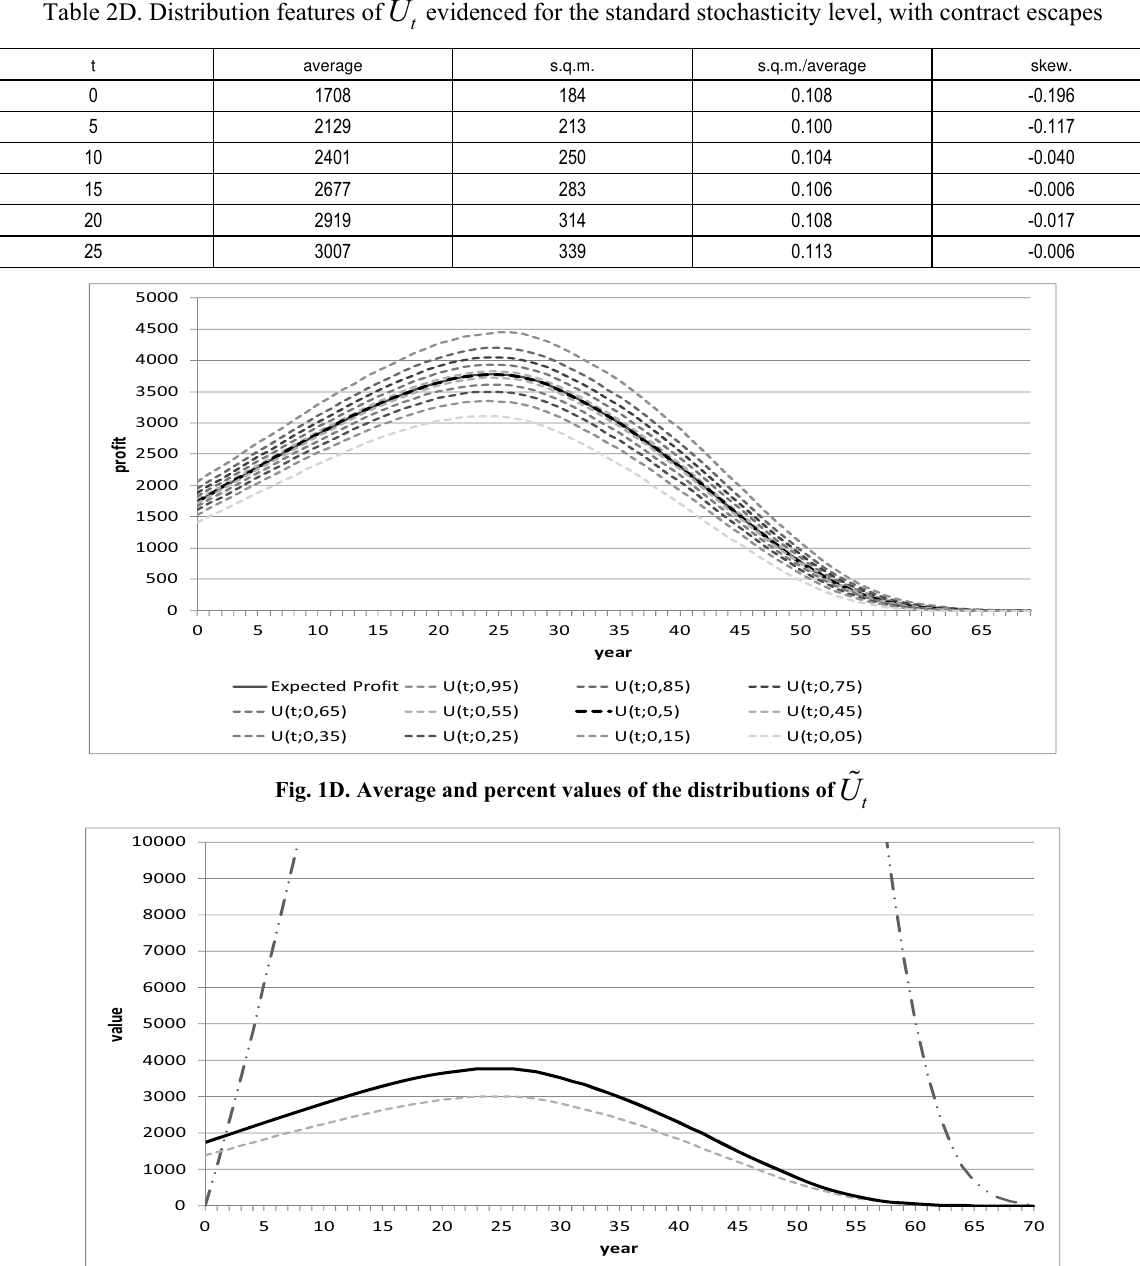
Table 2D. Distribution features of